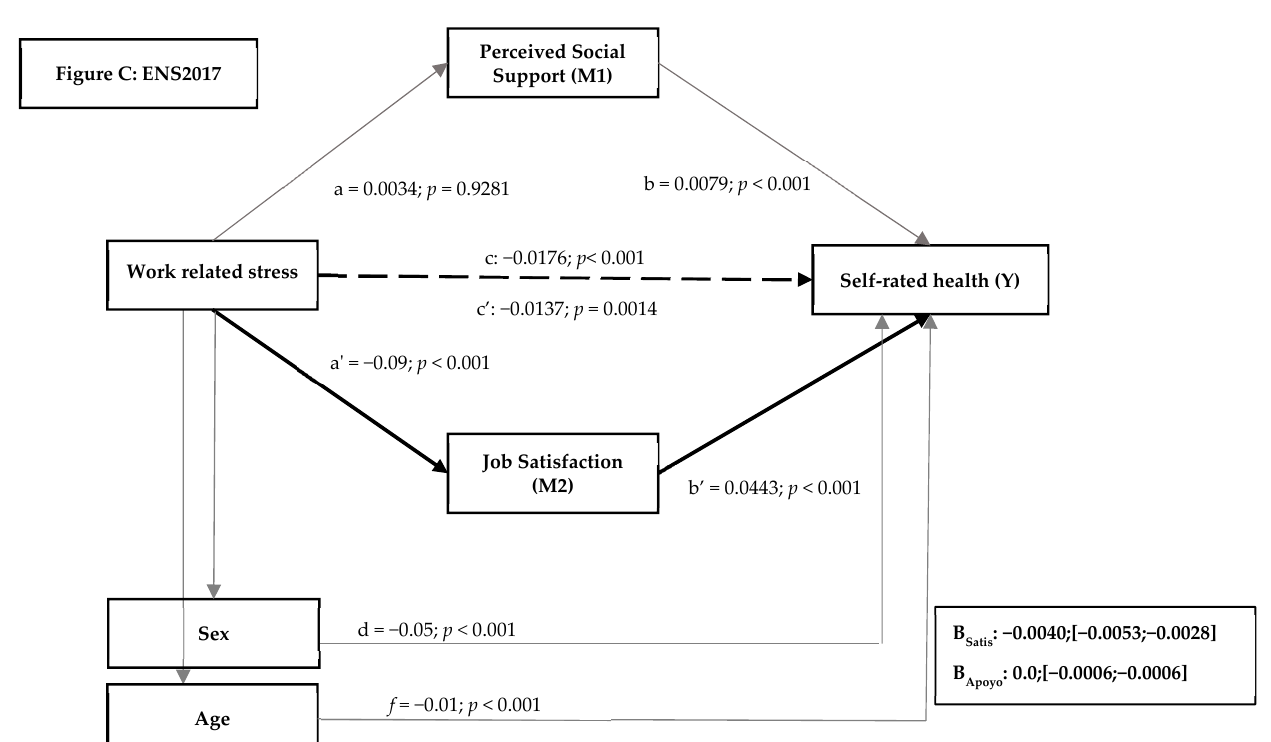
Figure 2. ( A – C ): Results of the mediation analysis. Criterion variable: self-perceived health, explanatory variable: job stress and mediating variables: job satisfaction and perceived social support, where a, b, c, a’, b’, c’ are the direct effects of medication. Indirect effects are represented by β job satisfaction (indirect effect of satisfaction) and β social support (indirect effect of perceived social support).